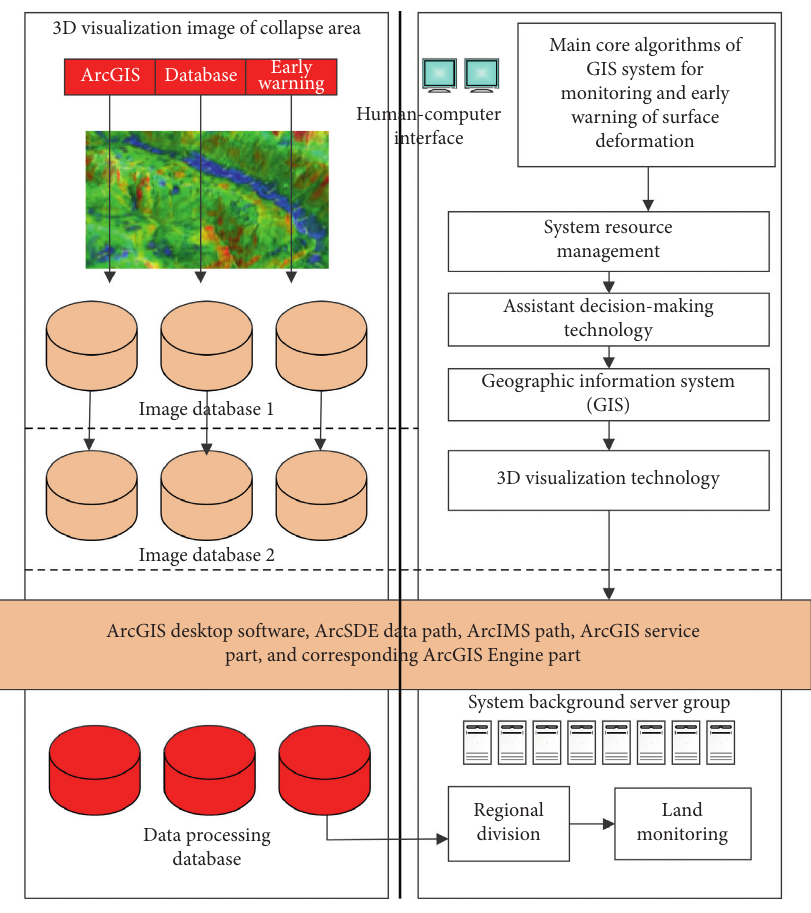
Figure 1: Framework of 3D visualization early warning and monitoring system for surface deformation based on GIS. Table 1: Details of mainstream parts of ArcGIS